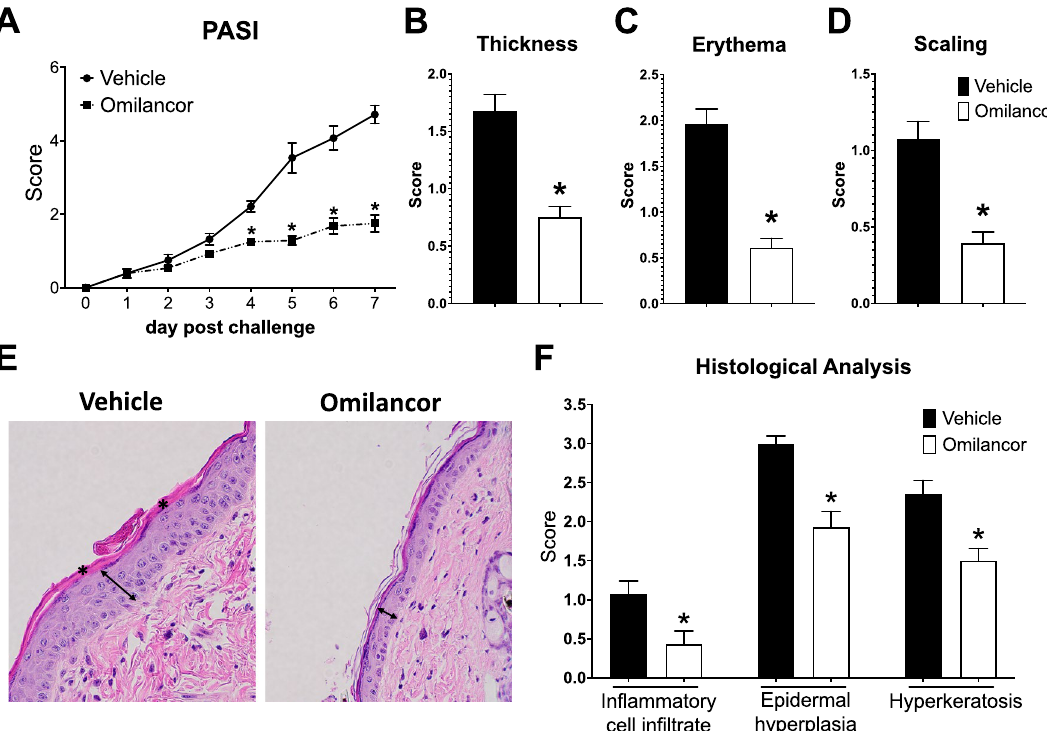
Figure 1. Therapeutic efficacy of topical omilancor treatment in an IMQ-induced model of PsO in dorsal skin. WT mice were shaved and challenged with IMQ treatment for 7 days. Vehicle or omilancor topical formulation was applied daily 1 h post IMQ challenge. Disease activity was monitored daily using a modified PASI ( A ). Skin thickness ( B ), erythema ( C ) and scaling ( D ) at day 7 post challenge. Representative photomicrographs of hematoxylin and eosin (H&E)-stained dorsal skin at day 7 ( E ). Epidermal hyperplasia ( ↔ ) and hyperkeratosis (*) are represented. Averaged histopathological scores for inflammatory cell infiltrate, epidermal hyperplasia and hyperkeratosis ( F ). * P ≤ 0.05.